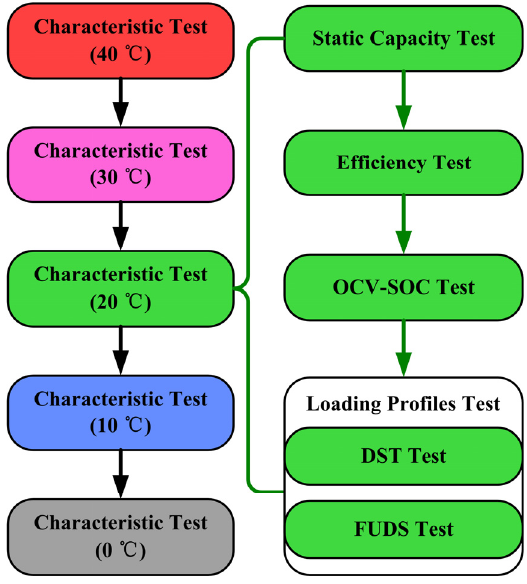
Figure 3. Battery experiment